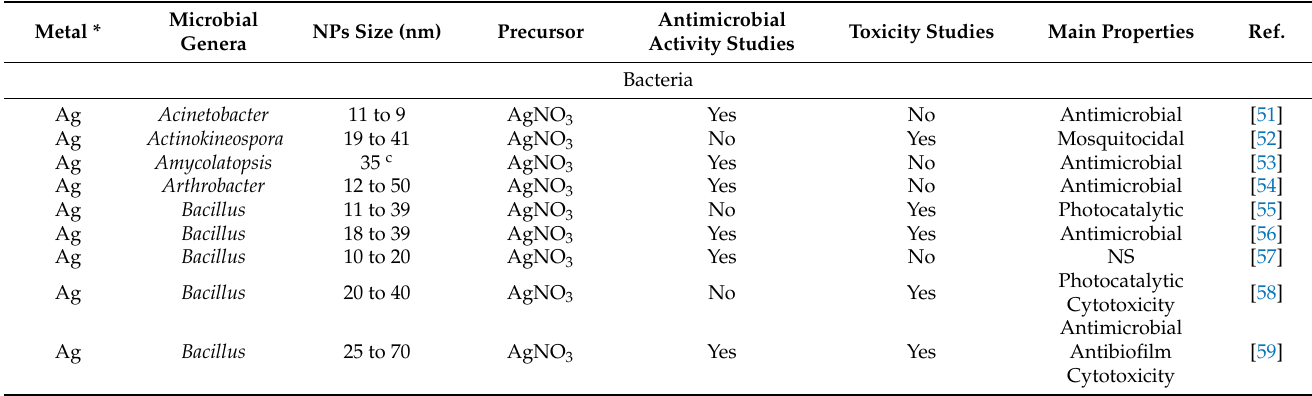
Table 1. Biosynthesis of metal nanoparticles using bacteria and archaea. Several examples of literature published in the last five years (2018–2022). The microbial genera, the metal and its precursor and the size of the metal nanoparticles obtained are presented. It is also stated whether the antimicrobial activity and toxicity of the nanoparticles were tested and which properties were